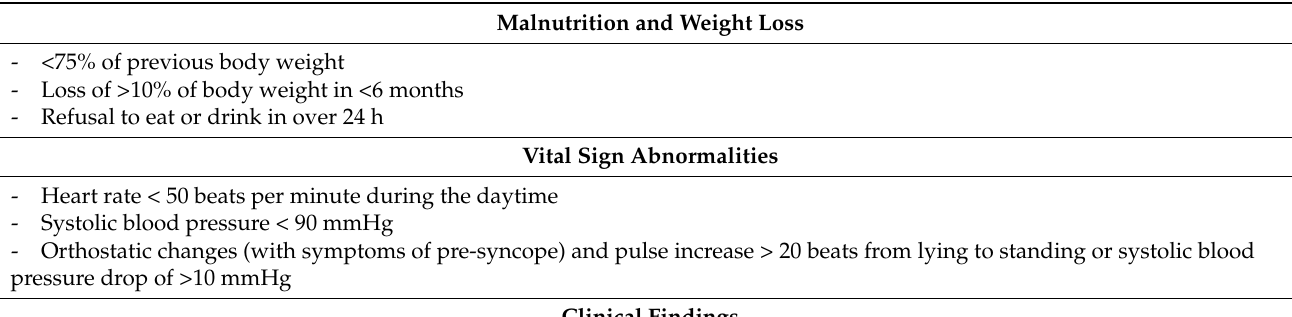
Table 1. Indications for urgent evaluation and